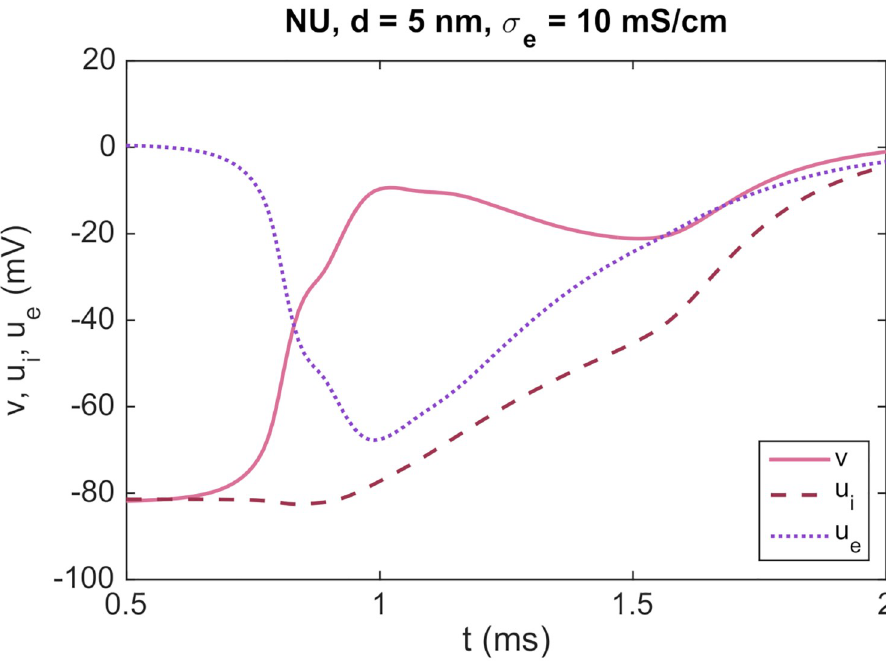
Fig 15. Propagation of an action potential through ephaptic coupling is achieved for a decreased extracellular conductivity. The figure shows the intracellular potential, the extracellular potential and the membrane potential observed after an intercalated disc with blocked gap junctions for a simulation with the same setup as in Fig 14, except that the value of σ is reduced from 20 mS/cm to 10 mS/cm. We consider a cell distance of d = 5 nm and a non- e uniform distribution of sodium channels.